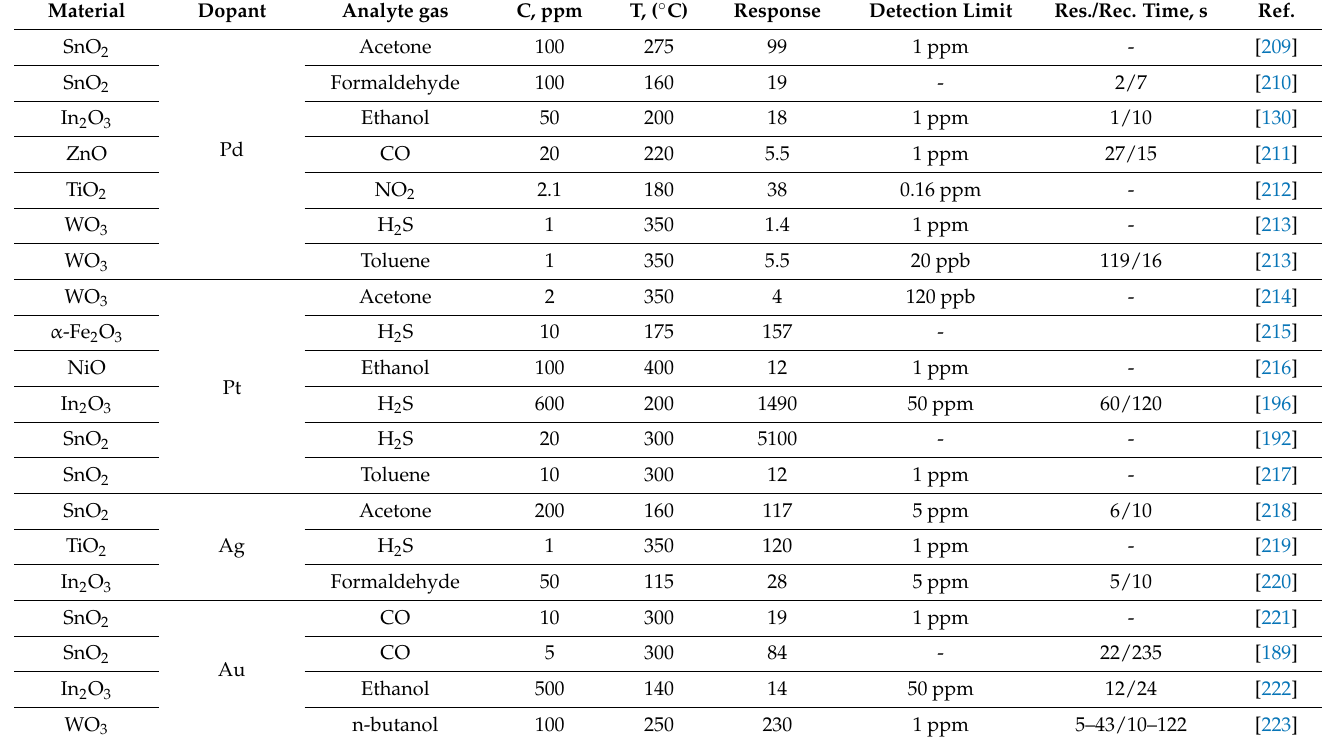
Table 3. Electrospun-based metal oxide gas sensors modified with noble